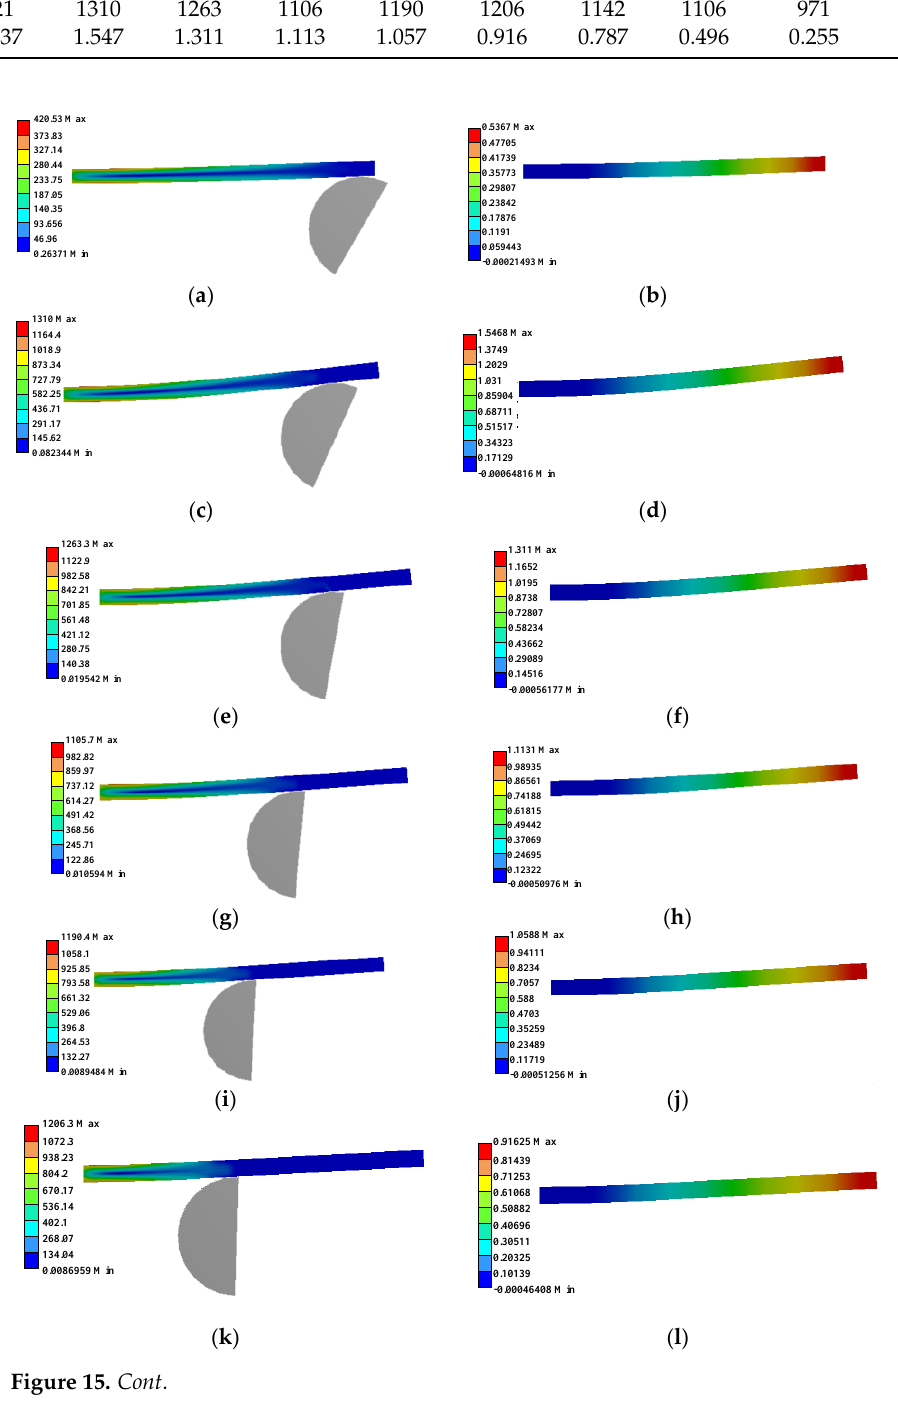
Table 2. Maximum stress σ max and deformation d ymax of the leaf spring.